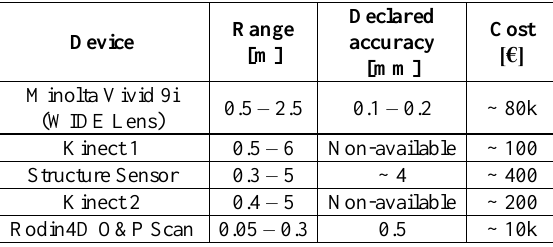
Table 1. Specifications of the tested